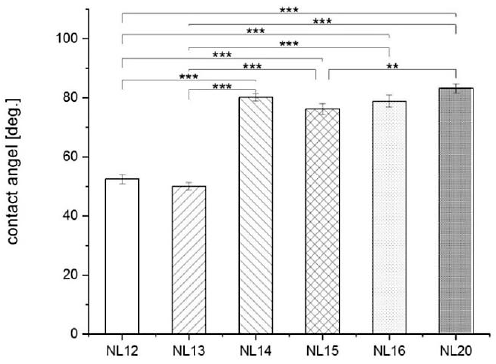
Figure 10. Water contact angle results of different polymers; mean ± S.E.M., n = 10. Asterisks show statistical significance at p** < 0.01, p*** < 0.001.